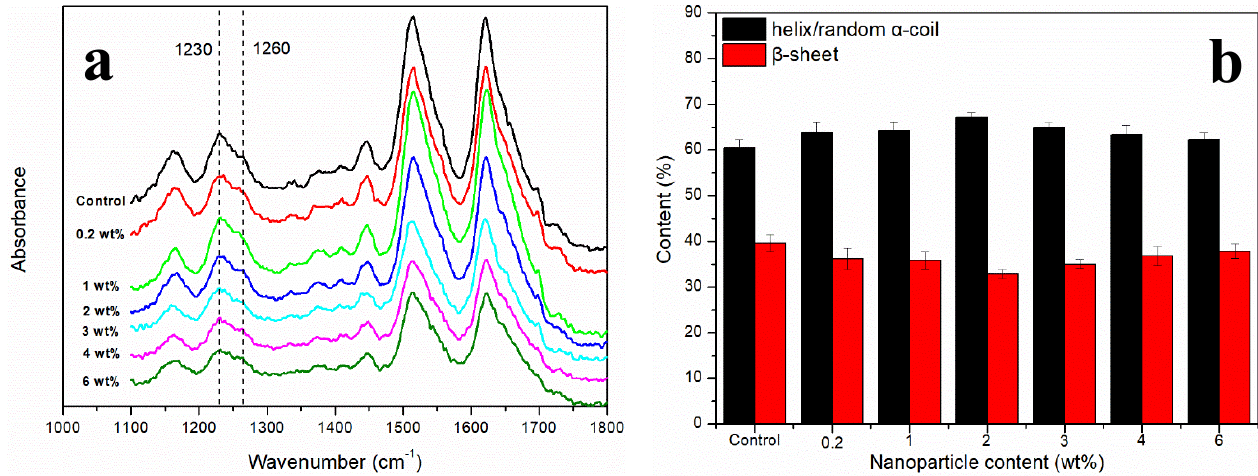
Figure 3. ( a ) FTIR of RSF/MoS 2 NPs hybrid fibers; ( b ) the contents of the secondary structures of RSF/MoS 2 NPs hybrid fibers.